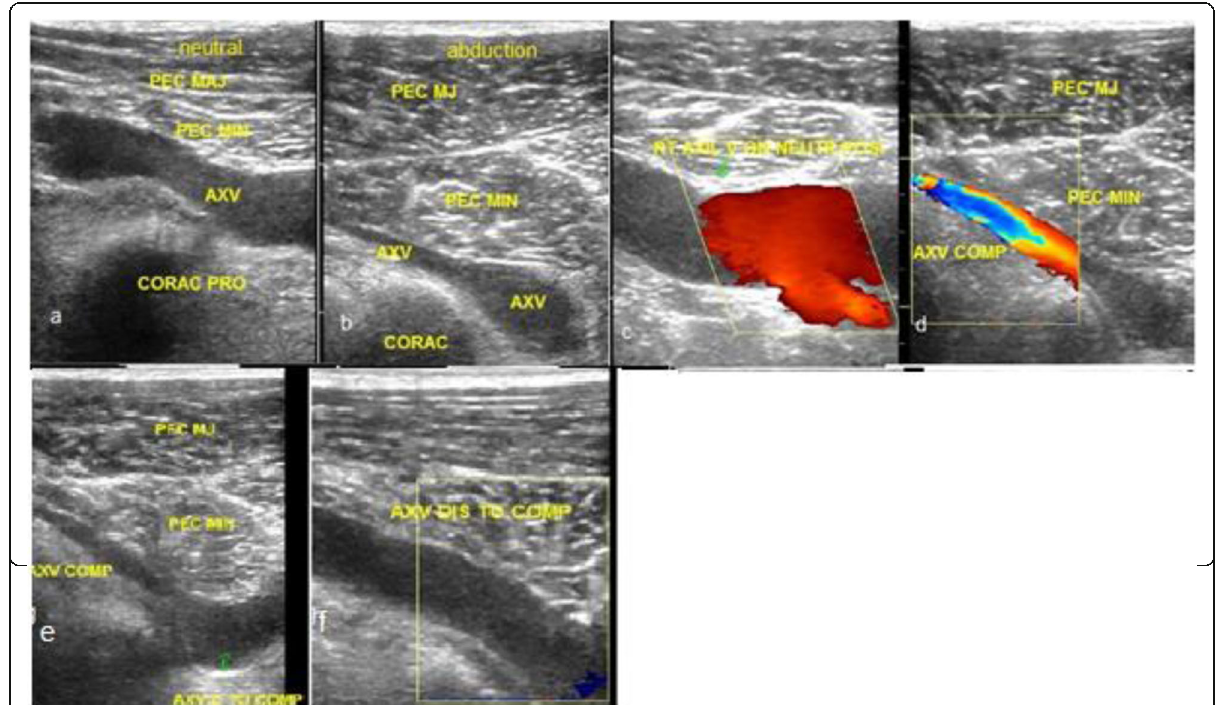
Fig. 6 B-mode ultrasound images for the axillary vein in the retro-pectoral\sub-coracoid space with the arm in the neutral position ( a ) and in arm abduction ( b ) showing marked compression of the vein by the overlying pectoralis minor muscle. Color Doppler images with the arm in the neutral ( c ) and in the abduction ( d ) positions showing significant stenosis with color aliasing in the compressed vein segment by the overlying pectoralis minor muscle. B-mode and color Doppler images of the axillary vein distal to the compression level showing the vein distension ( e ) with almost total cessation of the venous flow with the hyper-abduction ( f